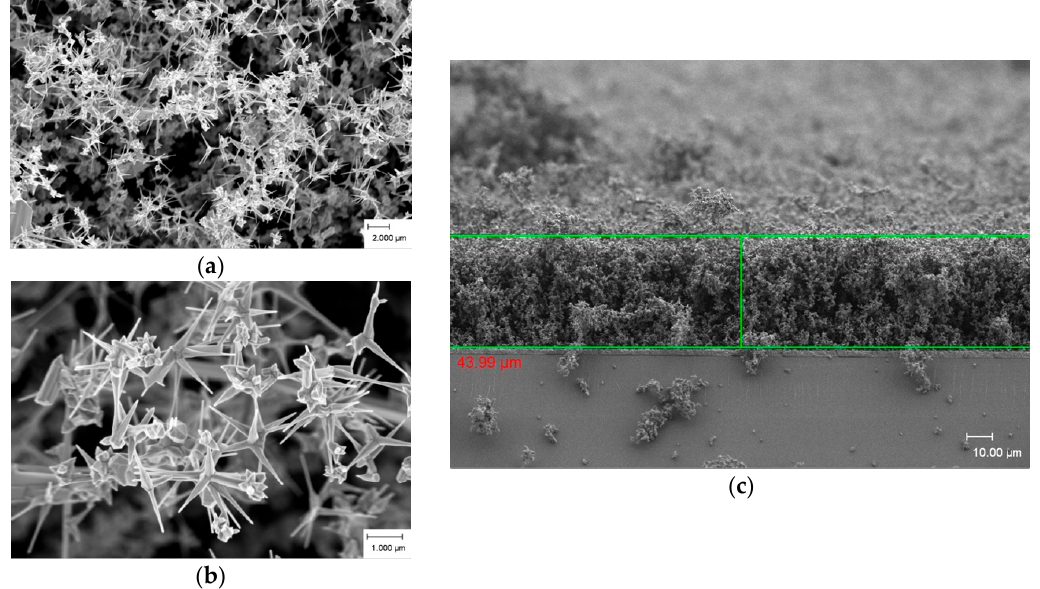
Figure 4. FESEM images of as-deposited ZnO products prepared at 600 ˝ C. ( a ) low magnification; ( b ) high magnification; and ( c ) cross section.